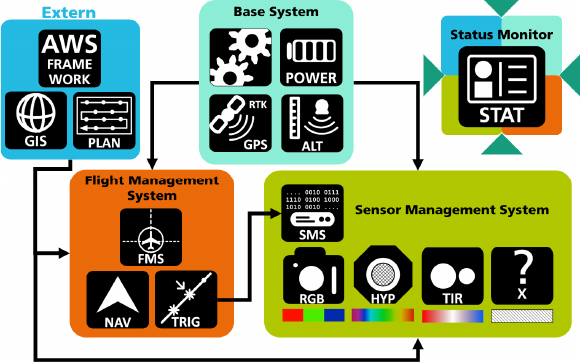
Figure 3. Schematic overview of the complete modularized system.